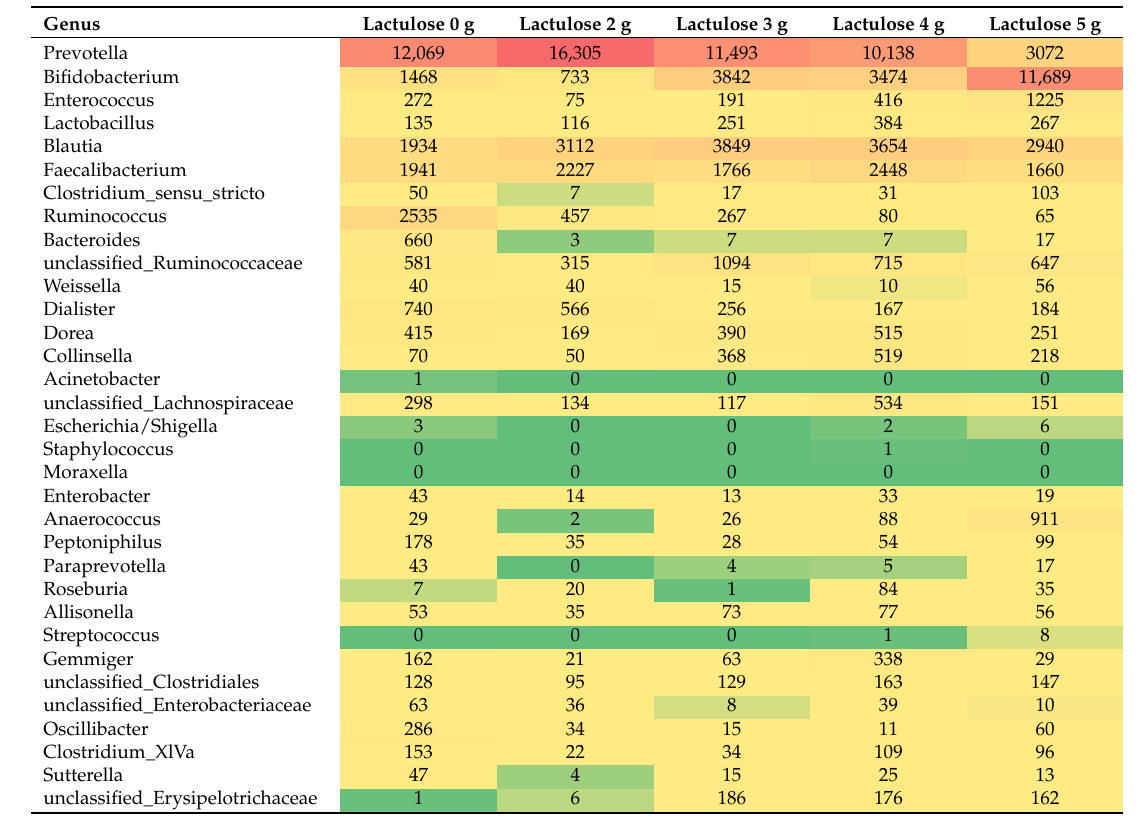
Figure 6. Heat map depicting fold changes of the increase in Bifidobacterium and Lactobacillus at different Lactulose doses compared to control after the 120 h test period in TIM-2 runs. A value equal to 1 (white) indicates no change, a value of >1 (green) indicates an increase, a value of <1 (red) indicates a decrease of the microbial genera. Table 2. The heatmap indicates the average relative number n of the different bacterial genera in the microbiota in the 5 different lactulose conditions 0 g, 2 g, 3 g, 4 g, and 5 g, respectively, after 120 h of exposure in TIM-2. The increasing reddish gradient color indicates the increase in the dominant genera in a particular sample ( n > 1000), the yellowish gradient color indicates the genera that are present at an intermediate level (9 < n < 1000) while the increasing greenish gradient color represents the genera that are becoming more marginally present in the microbiota ( n < 10).